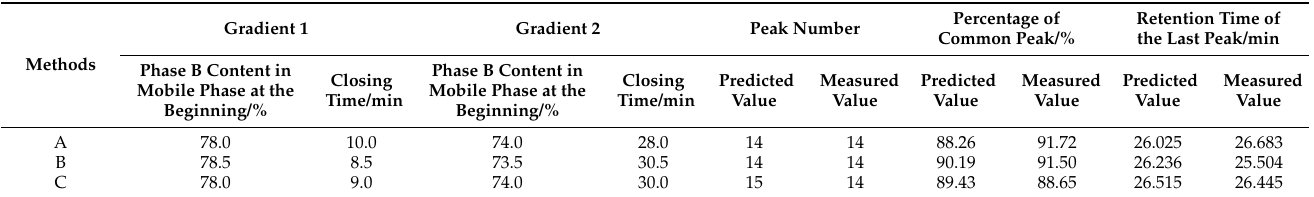
Table 6. Validation of experimental conditions and